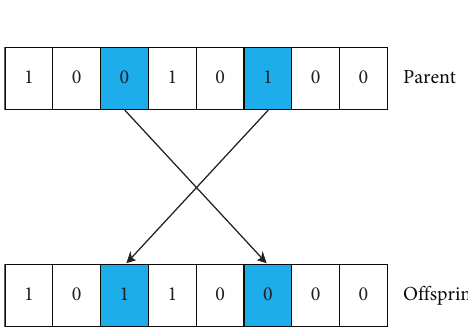
Figure 4: N -point crossover.